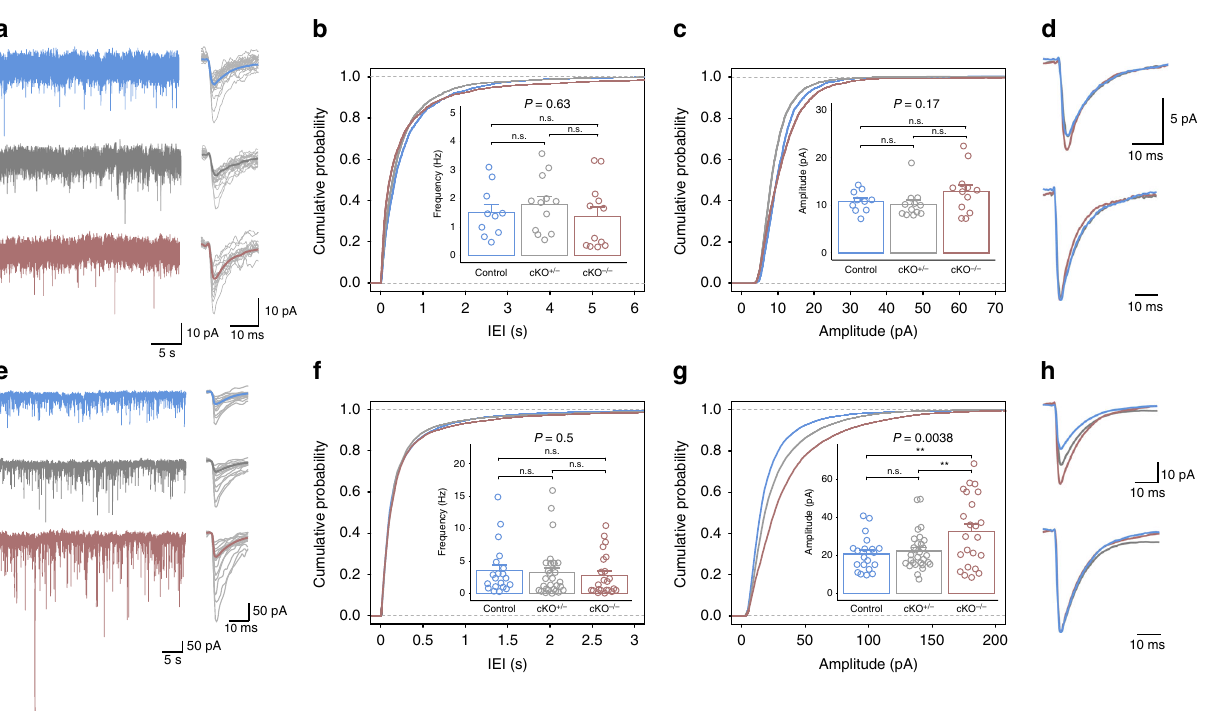
Fig. 7 Purkinje cells in Pogz -de fi cient mice show an increase in amplitude of inhibitory input, while the excitatory input is unaffected. a Continuous recordings of sEPSCs from PCs in voltage clamp mode of all genotypes; superpositioned events including the averaged event (in color) are presented on the right. b Comparison of the frequency of the sEPSCs (inset, n = 10/2 control (blue), 12/2 cKO + / − (gray), 12/2 cKO − / − (red)) and the cumulative probability of the inter-event interval (IEI) of all genotypes ( n {IEIs per genotype} = 1814 control, 2569 cKO + / − , 2197 cKO − / − ). c Same as ( b ) for the amplitude of the sEPSCs ( n {events per genotype} 1824 control, 2581 cKO + / − , 2209 cKO − / − ). d Top: The averaged sEPSC of all cells of each genotype. Bottom: Same as in Top after normalization. e Continuous recordings of sIPSCs recorded from PCs in voltage clamp mode of all genotypes; superpositioned events including the averaged event (in color) are presented on the right. f Comparison of the frequency of sIPSCs (inset, n = 20/5 control, 29/5 cKO + / − , 23/4 cKO − / − ) and the cumulative probability of the inter-event interval (IEI) of all genotypes ( n {IEIs per genotype} = 8516 control, 11137 cKO + / − , 7696 cKO − / − ). g Same as ( f ) for the amplitude of the inhibitory events ( n {events per genotype} 8536 control, 11,160 cKO + / − , 7719 cKO − / − ). Note the genotypes differences as manifested in the cumulative probability for the amplitudes of the inhibitory events. h Top: The averaged sIPSC of all cells of each genotype. Bottom: Same as in Top after normalization. The P values at the top of the plots are for association between the quantitative measurements and the number of intact Pogz alleles calculated with a linear regression model. Pairwise comparisons between genotypes were calculated by two-tailed t test and the signi fi cance is represented by: ** P < 0.01; n.s. not signi fi cant. Quantitative data are mean ±